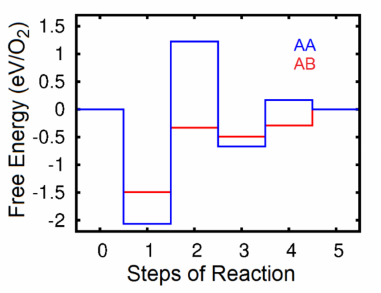
Figure 8. Free energy diagram of the steps of oxygen reduction reaction (ORR) in alkaline media for two di ff erent types of stacking of